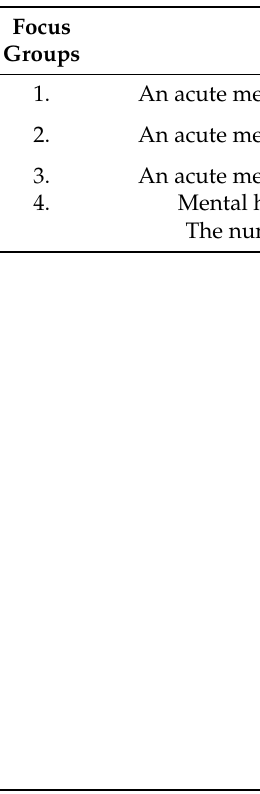
Table 1. The context of the